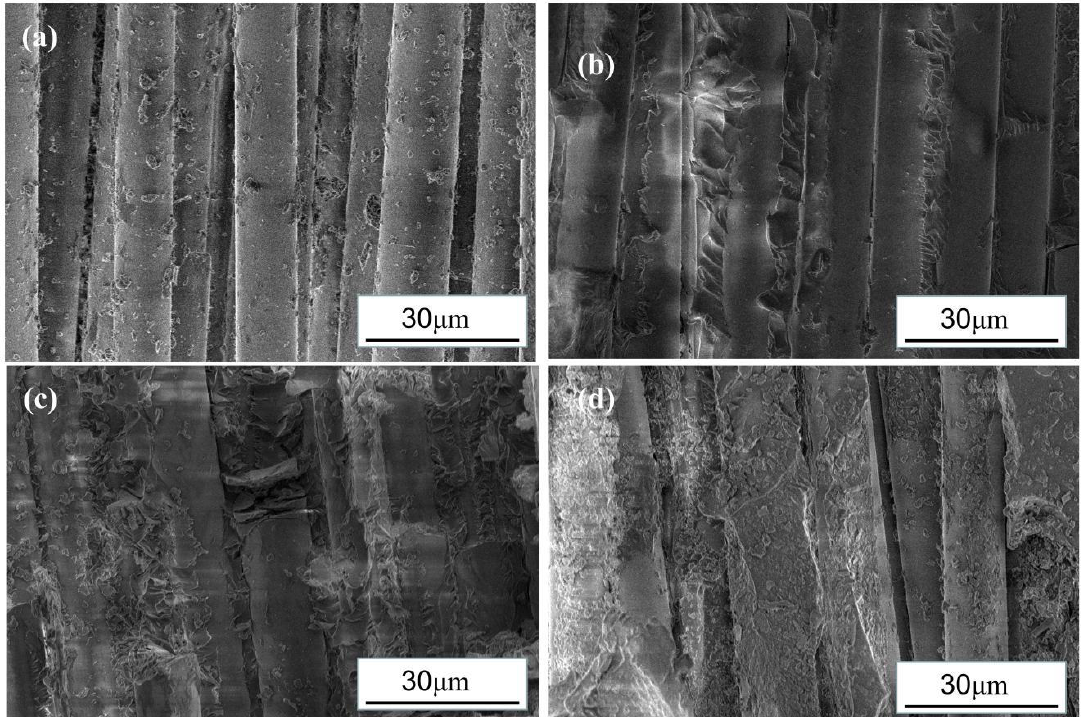
Figure 11. SEM images of shear fracture surface of composites treated with different mass fraction of SiO 2 -COOH. ( a ) ABFRP, ( b ) 0.5-SiO 2 -BFRP, ( c )1-SiO 2 -BFRP, ( d ) 1.5-SiO 2 -BFRP. DMA